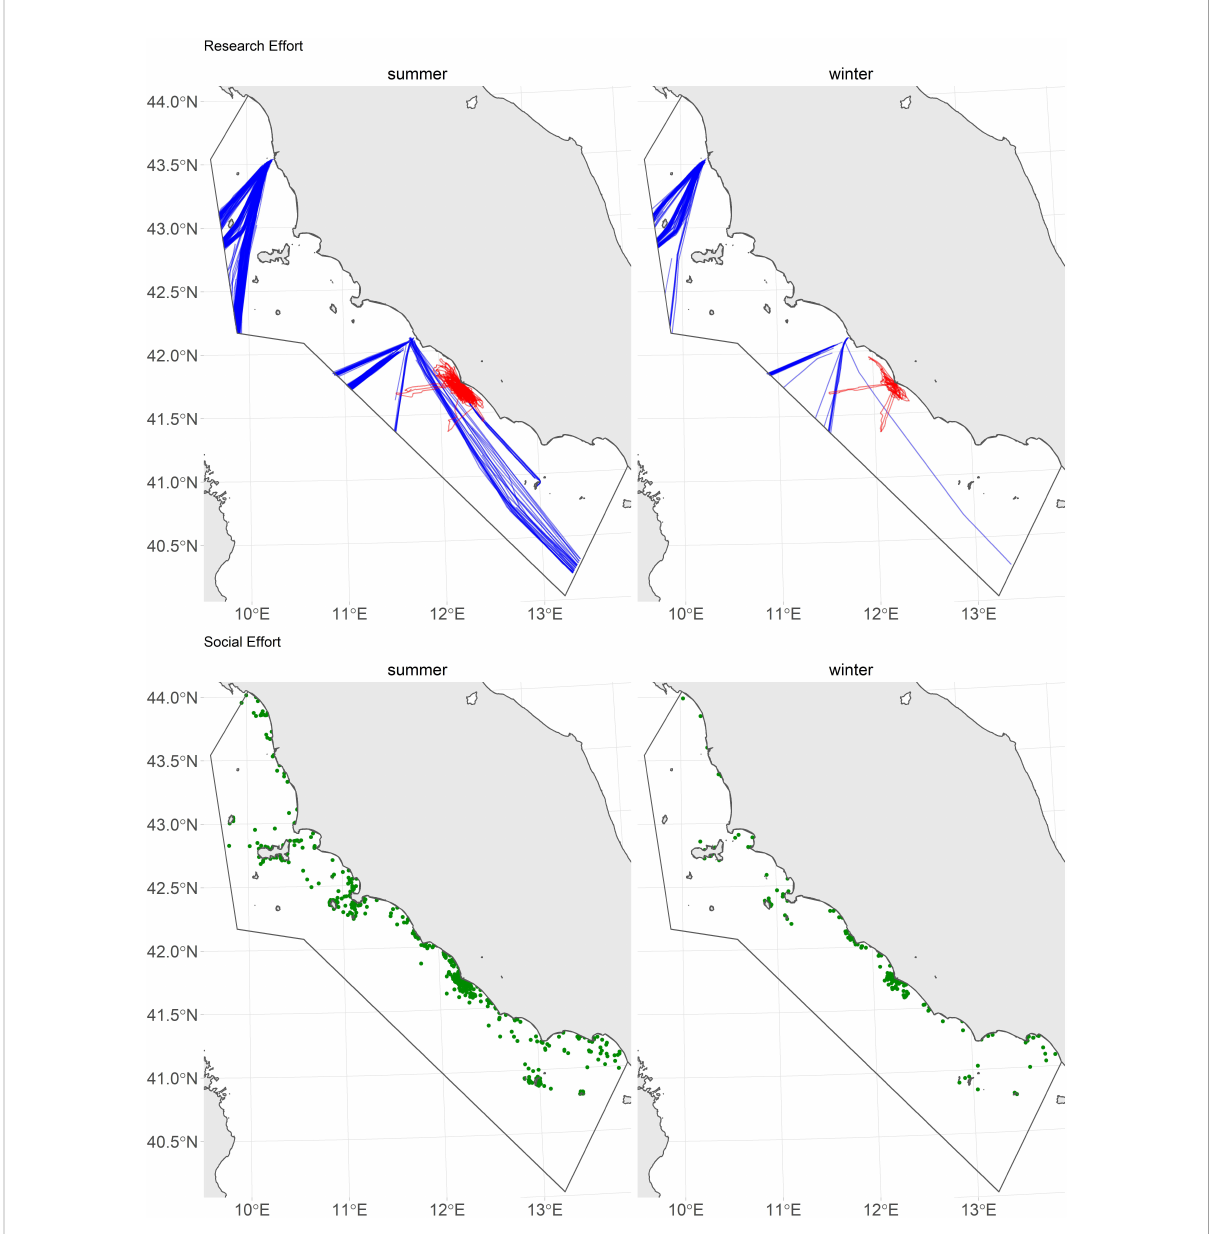
FIGURE 2 Total research effort by UNIRM (red) and FLT Net (blue) research programs and point location of social media sightings (green